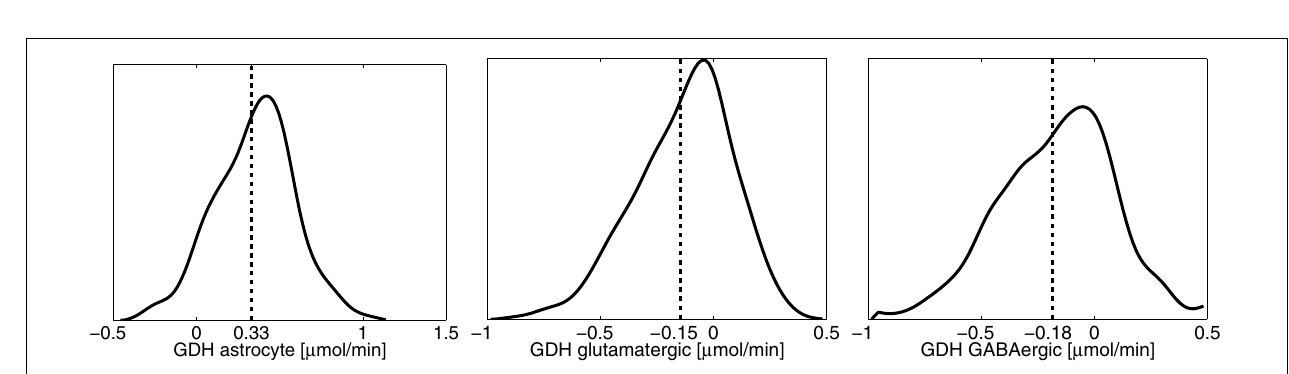
glutamine uptake and PAG. Of all GABA produced, 35% enters the mitochondria where it is transaminated by GABA-T and further oxidized.The glutamine influx comprises about 70% of the transmitter GABA efflux, although the complex pathway pattern complicates the tracking of the precursors.